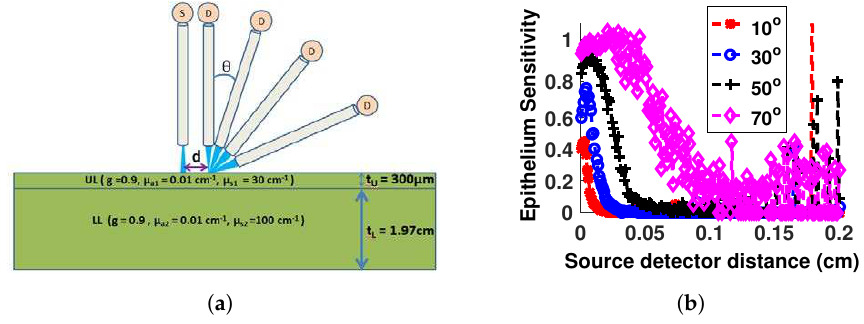
Figure 1. ( a ) Source-detector geometry in which detector fibers are at 10 ◦ ,30 ◦ ,50 ◦ ,70 ◦ bevel angles, ( b ) variation of epithelium sensitivity with bevel angles and source-detector distances, plot with red curve shows spatially resolved epithelium sensitivity at a 10 ◦ bevel angle and similarly, blue, black and magenta curves represent epithelium sensitivity at 30 ◦ , 50 ◦ , and 70 ◦ bevel angles respectively (color online